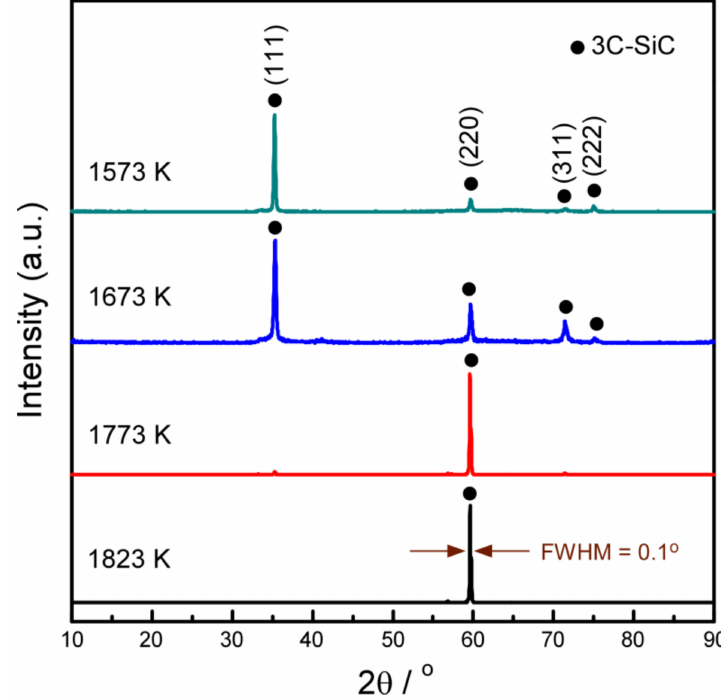
Figure 1. X-ray diffraction (XRD) patterns of the 3C-SiC deposit at various T dep